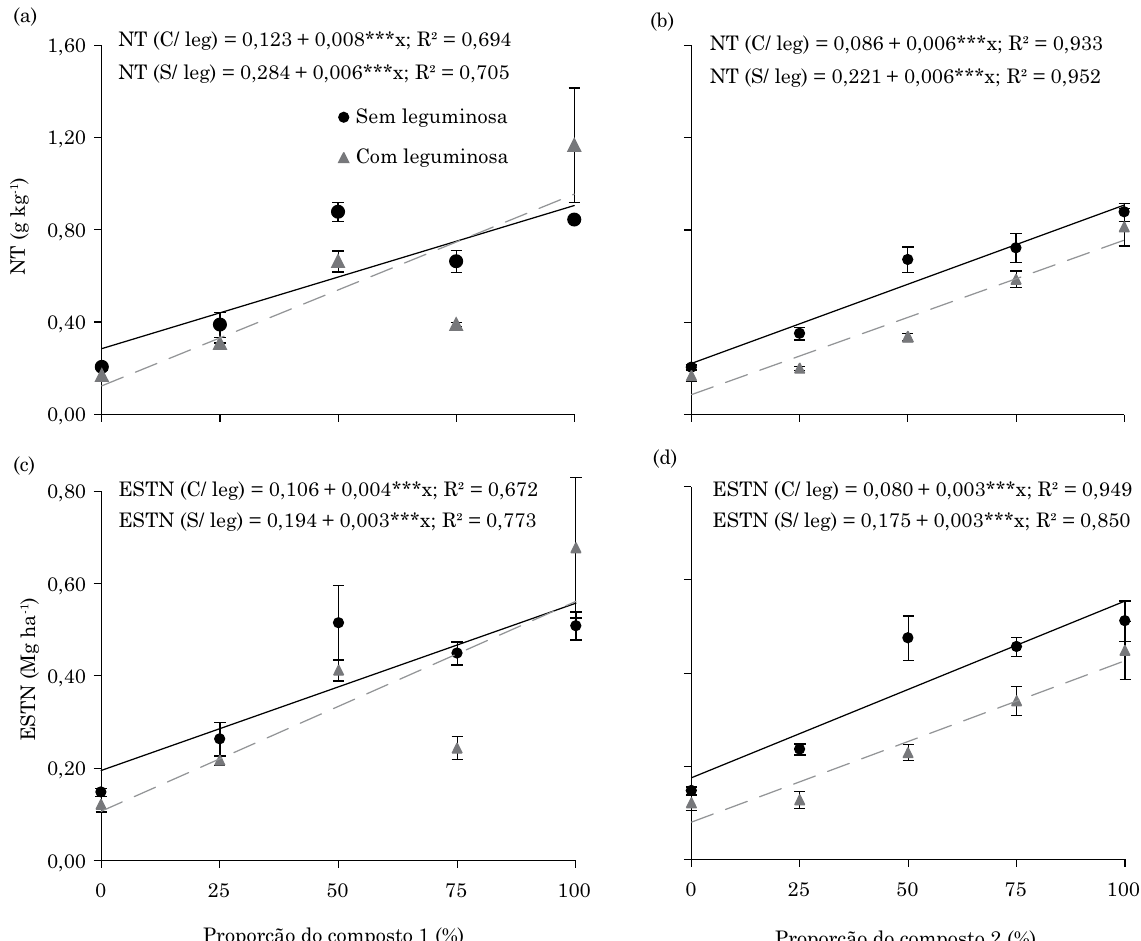
Figura 4. Nitrogênio total (NT) (a, b) e estoque de nitrogênio (ESTN) (c, d) após 30 dias da 1ª etapa da adubação do 2º ano agrícola (2010/2011) (profundidade de 0,00-0,05 m) em razão das proporções (%) do composto 1 (a) e composto 2 (b), na presença e ausência da leguminosa (feijão-de-porco). DMS (Tukey a 10 %) para o estudo do fator leguminosa nas proporções dos compostos – NT: 0,1638; ESTN: 0,1128. Barras na vertical: erro padrão. ***, ** e *: significativo a 1, 5 e 10 %,